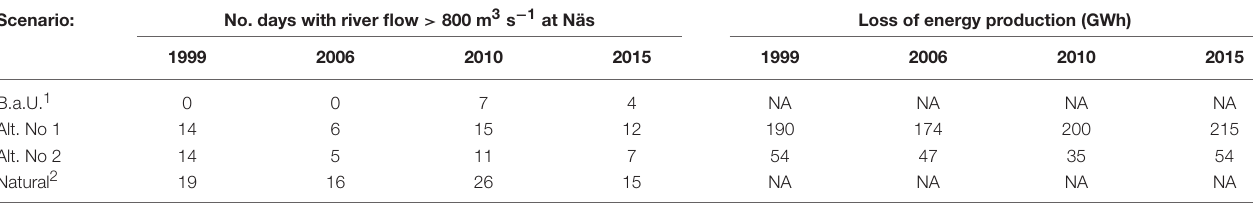
TABLE 1 | Number of days and production losses for different scenarios of artificially induced floods (modified from Hedström-Ringvall et al., 2017a).